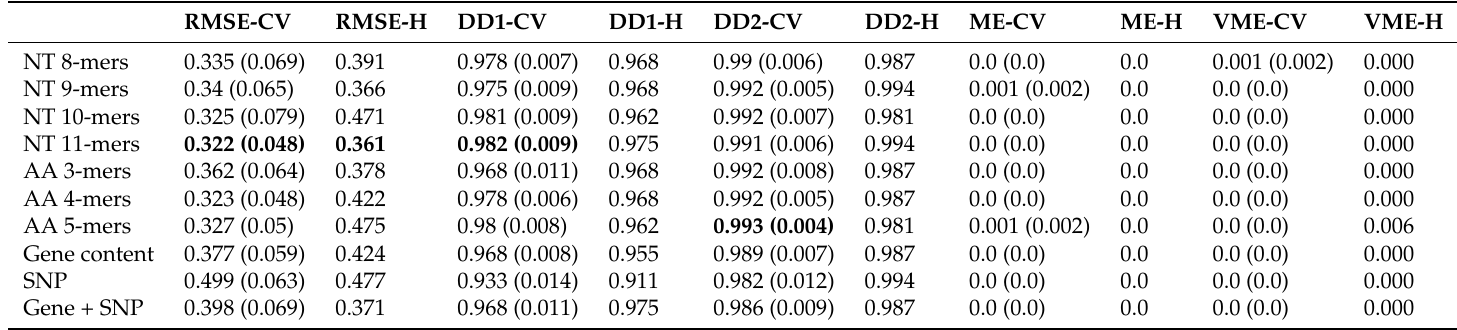
Table A44. K. pneumoniae